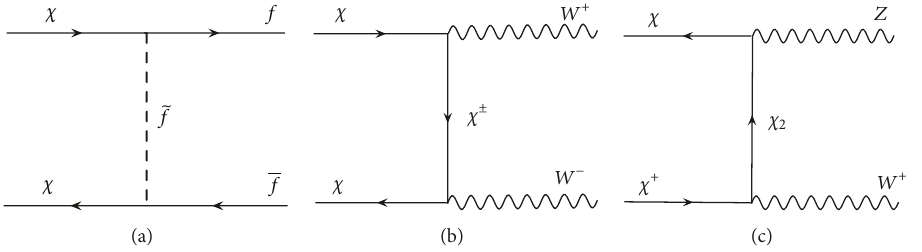
Figure 1: (a) The dominant early-Universe annihilation channel for a nearly pure bino-like neutralino. (b), (c) Examples of annihilation and coannihilation tree-level channels into gauge bosons for a predominantly higgsino-like neutralino.